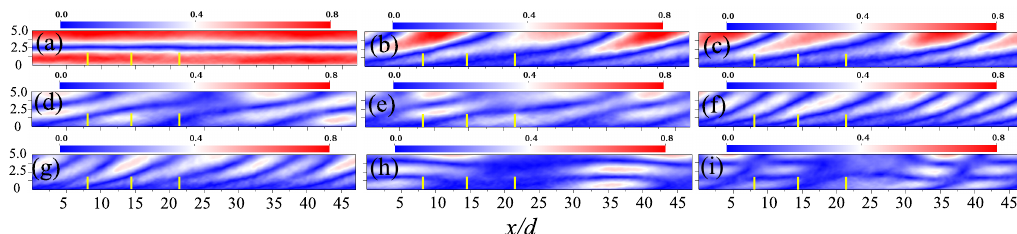
Figure 13. Normalized Fourier-POD mode for wave-number (POD of spanwise averaged snapshot data), k y d = 0. ( a ) m = 0, ( b ) m = 1, ( c ) m = 2, ( d ) m = 3, ( e ) m = 4, ( f ) m = 5, ( g ) m = 6, ( h ) m = 7, ( i ) m = 8. Red-blue contours indicate the normalized velocity magnitude modes, yellow vertical lines–turbine locations.